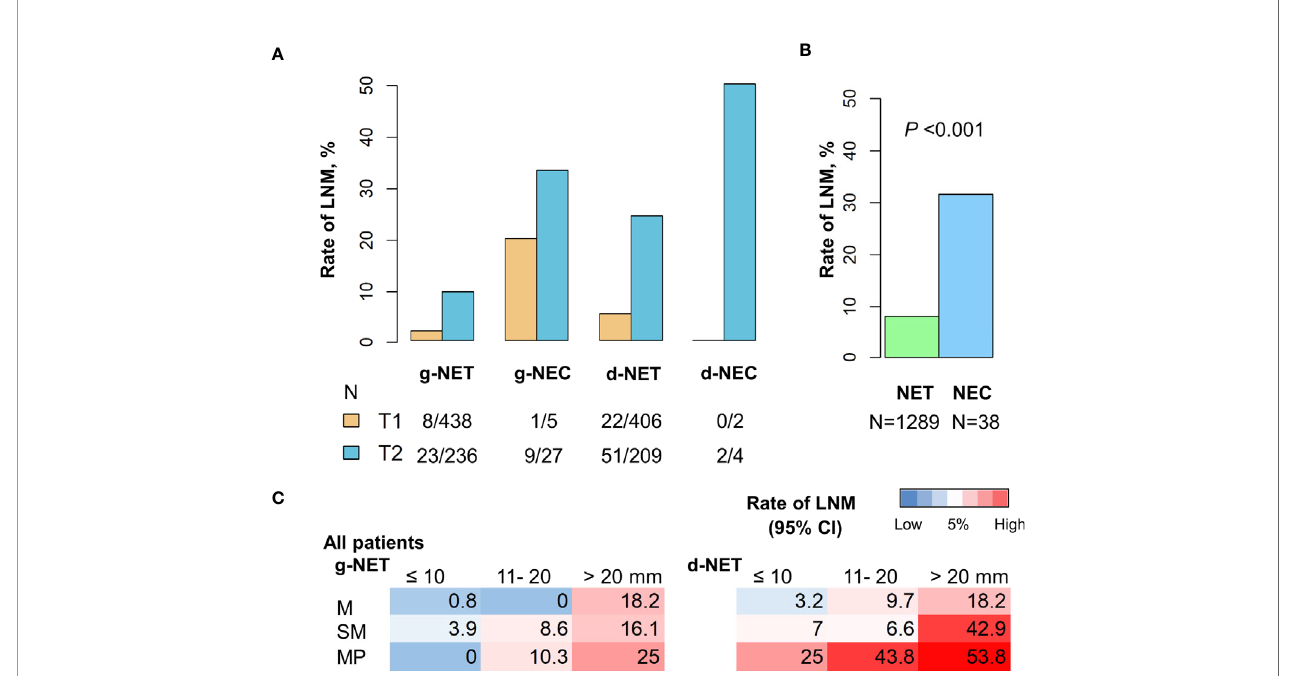
FIGURE 1 | Incidence of LNM in patients with g-NENs and d-NENs. (A) LNM rates in T1 and T2 stages strati fi ed by tumor differentiation. (B) Comparison of LNM rates in all NETs (n = 1289) and all NECs (n = 38). (C) Risk of LNM in NETs with different invasion depths and sizes. g-NEN, gastric neuroendocrine neoplasm; d-NEN, duodenal neuroendocrine neoplasm; LNM, lymph node metastasis; NET, neuroendocrine tumor; NEC, neuroendocrine